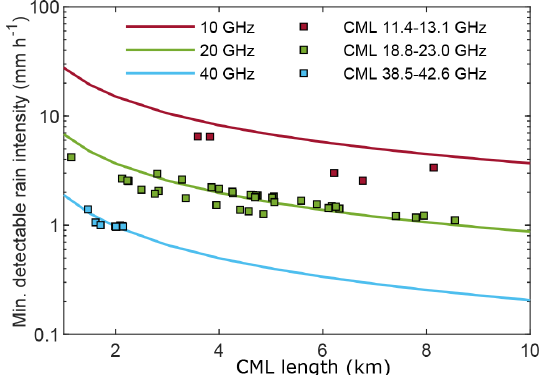
Figure 3. Minimum detectable rainfall intensity as a function of path length for link frequencies of 10, 20, and 40GHz, assuming a 1dB quantization step on RSL. Squares represent the frequency and length of the 50 available CMLs in the study